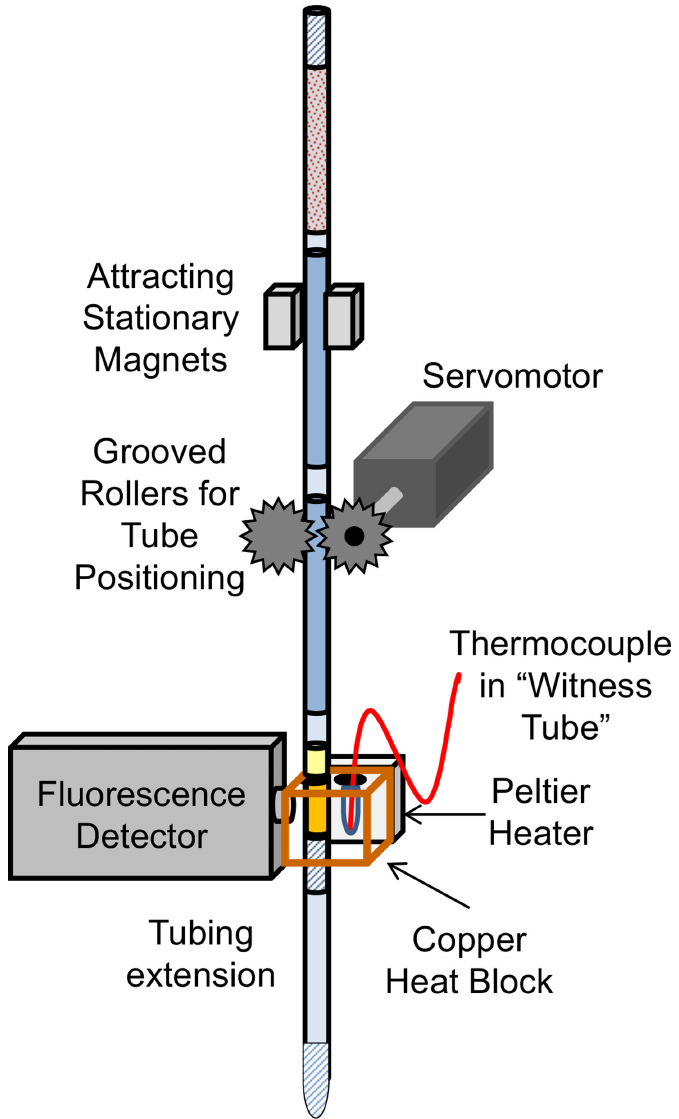
Fig 2. Integrated DNA extraction and amplification device. The extraction tubing was raised and lowered between attracting magnets to move the binding beads through the solutions into the isothermal reaction chamber. After the DNA eluted from the beads, the LAMP solution chamber was positioned for amplification in a copper heat block. The block held the reaction chamber at 65°C while the detector measured fluorescence over time. Diagram not to